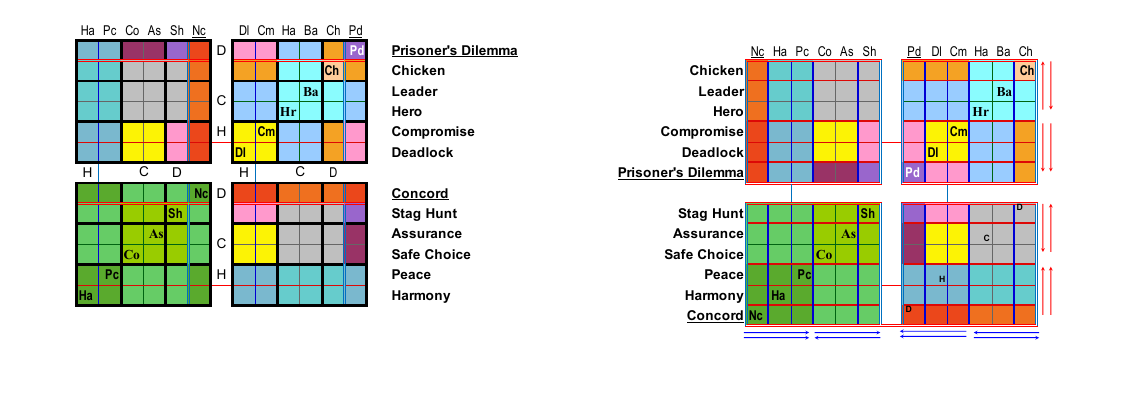
MhMk:Jekyll-Hyde Dissonance Samaritan D